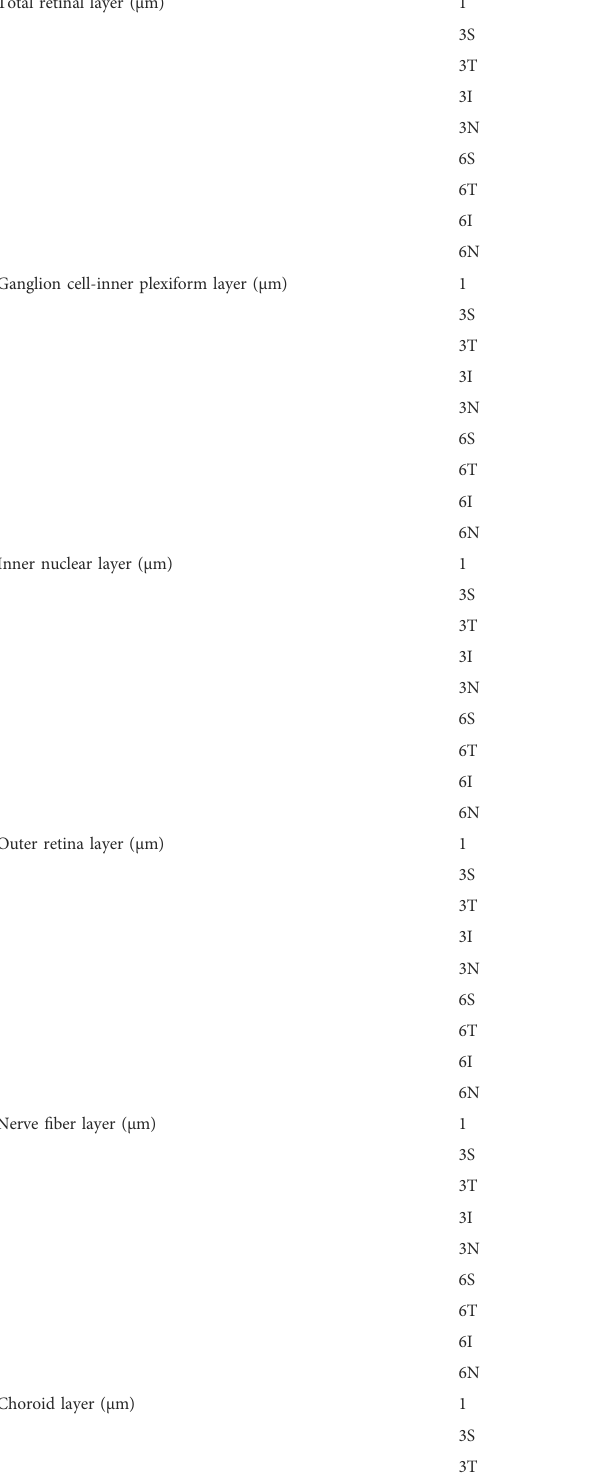
TABLE 4 Analysis of correlations between the regional thickness of each retinal layer, choroidal layer, and axis length Total retinal layer ( μ